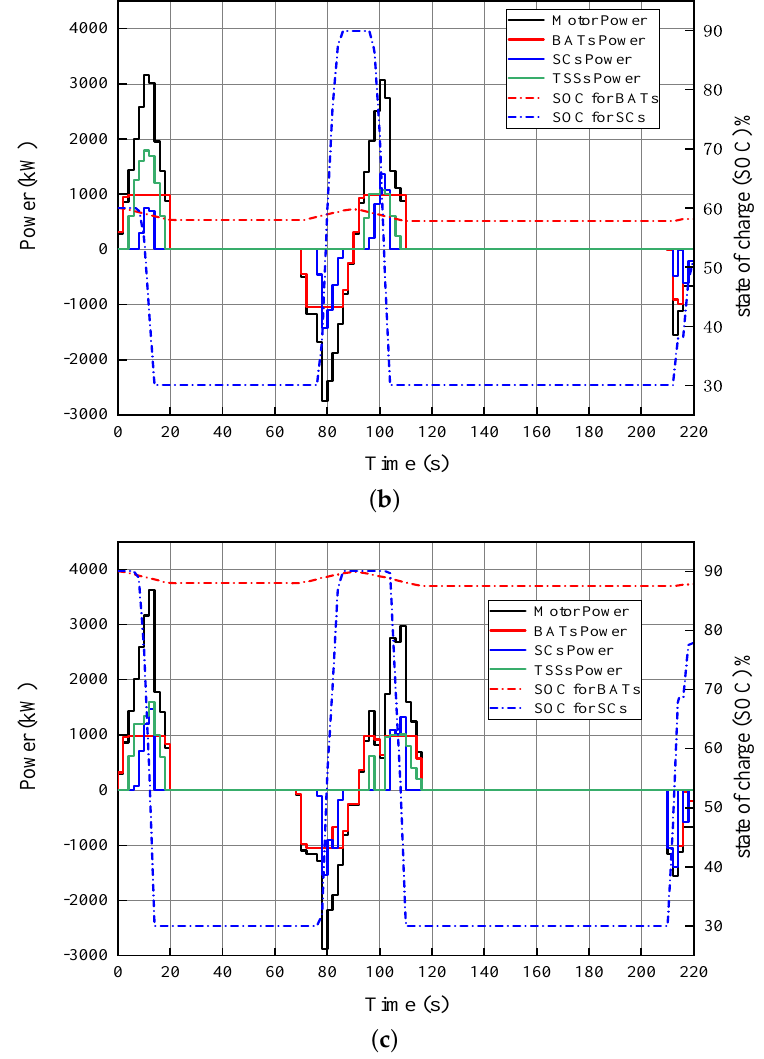
Figure 11. The motor power, TSSs power, discharge/charge power of on-board HESDs and SOC curves for cases 4–6. ( a ) case 4. ( b ) case 5. ( c ) case